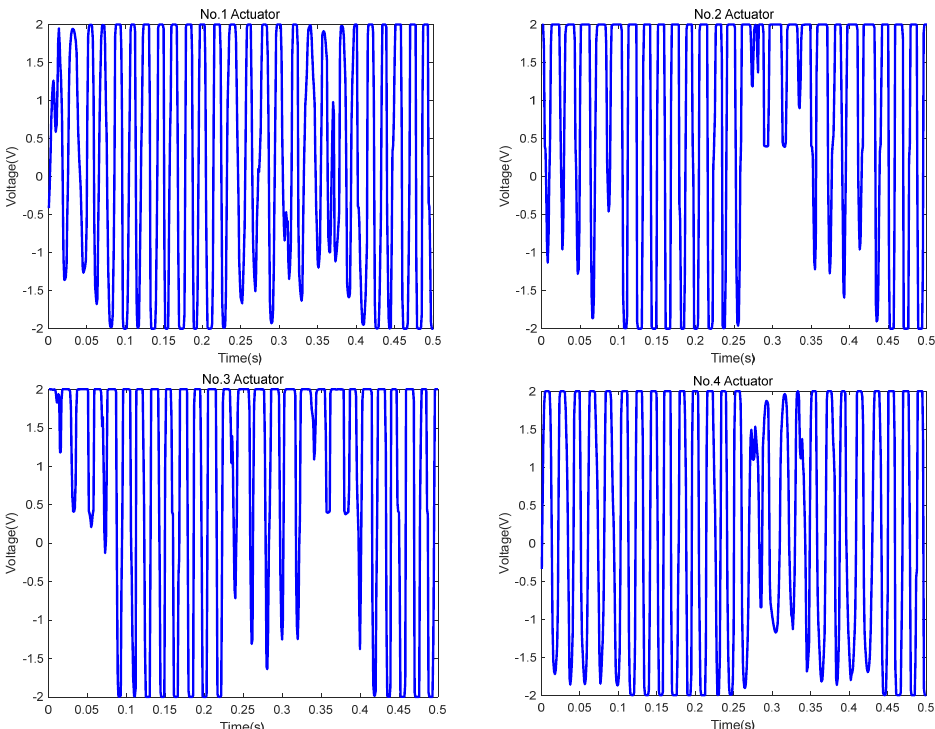
Figure 14. PSDs of sensor signals obtained by experiments. Table 3. RMS values of sensor signals: Experiment #1.